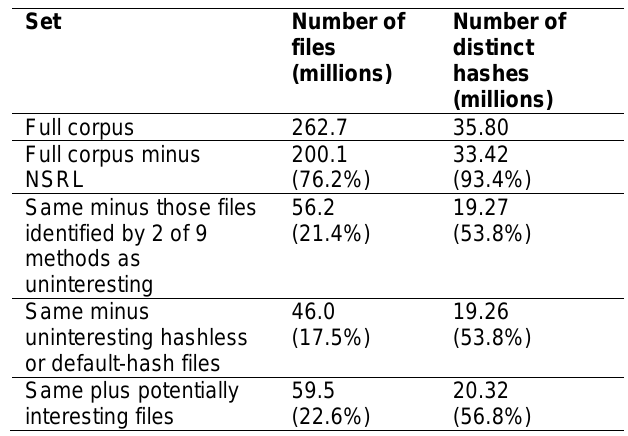
Table 8. Overall statistics on file and hash elimination and their data reduction